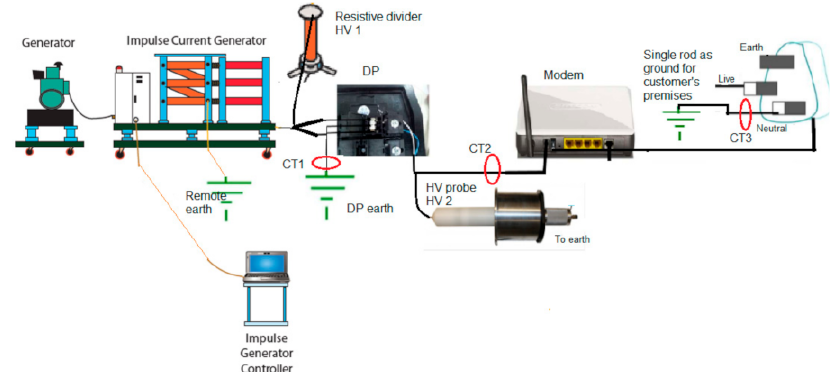
Figure 1. Test arrangement used in the study.